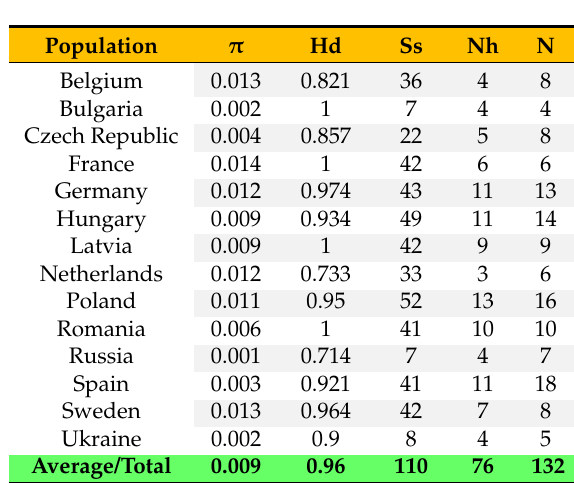
Table 1. Molecular diversity indexes for the 14 populations of breeding Red-backed Shrike (RBS), obtained from the concatenated genes cytochrome oxidase B ( Cytb ) and cytochrome c oxidase subunit 1 ( CO1 ).